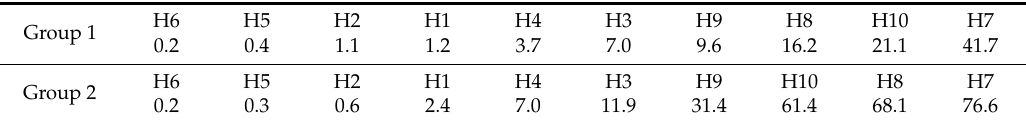
Table 4. Overall performance rankings (RPD) of proposed heuristics in relation to EM for Group 1 and to the best found solution for Group 2.